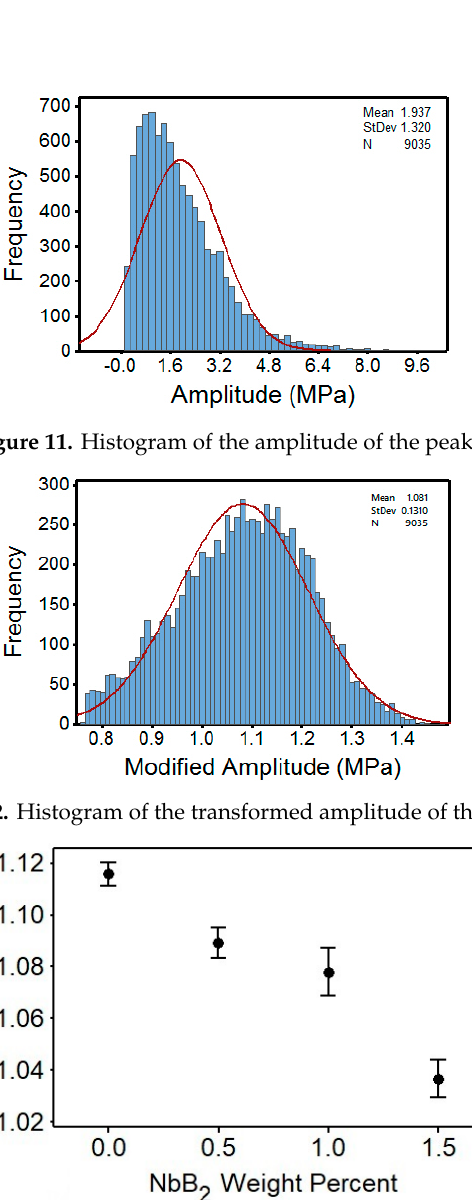
Figure 13. The amplitude of the serrated signal upon PLC.